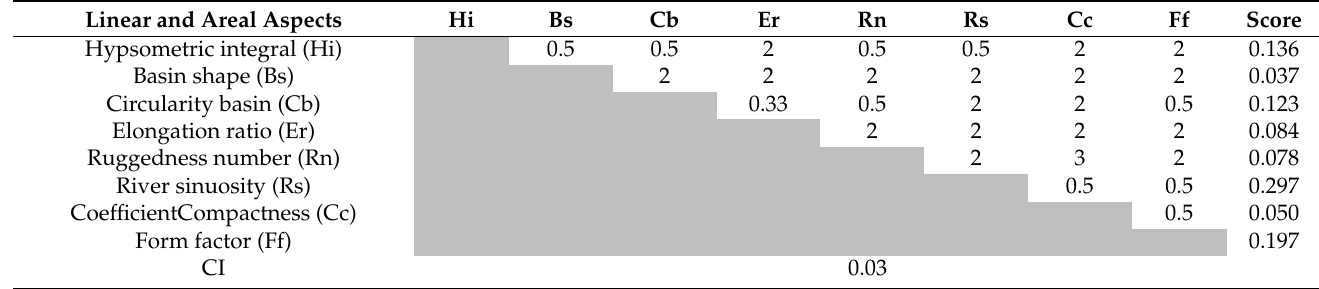
Table 2. Pairwise comparison matrix for standardizing factor